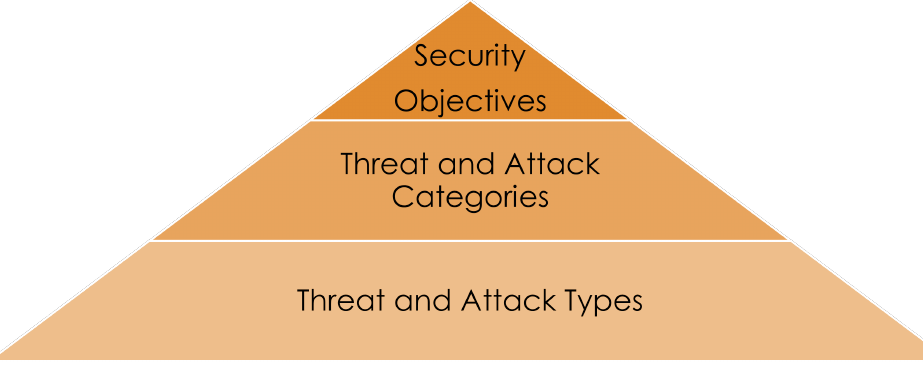
Figure 2. Levels of abstraction for Smart Grid Security analysis. Adapted from